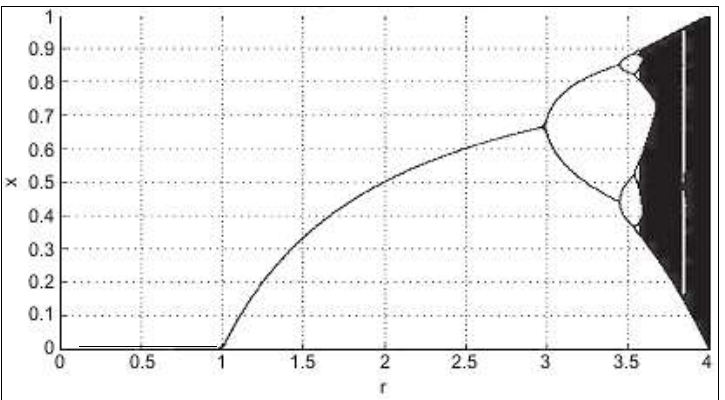
Fig.1: Bifurcation for the logistic